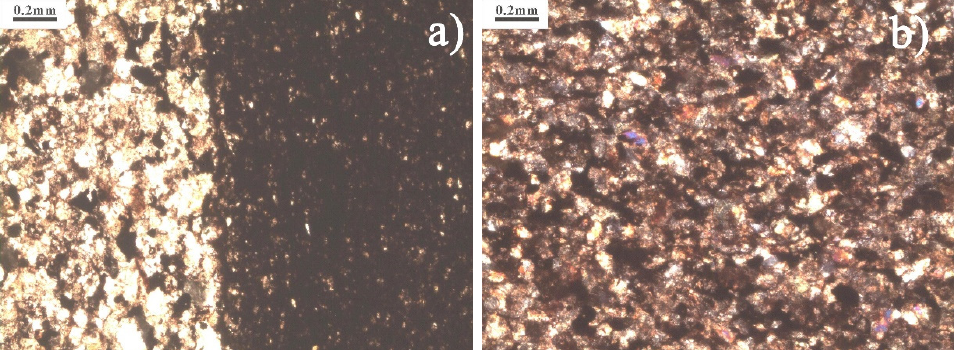
Figure 2. Red shale’s polarizing microscope graph. Note: ( a ) plane polarized light; ( b ) perpendicular polarized light.